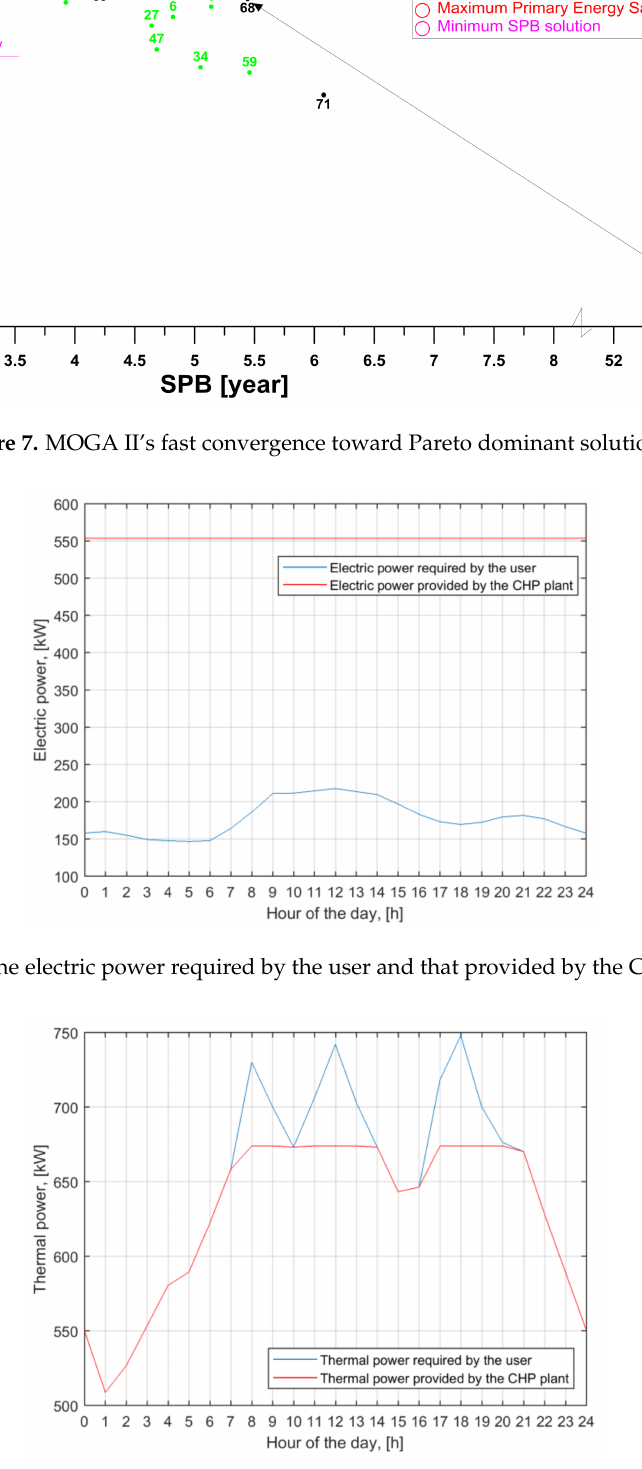
Figure 9. The thermal power provided by the CHP plant and that required by the